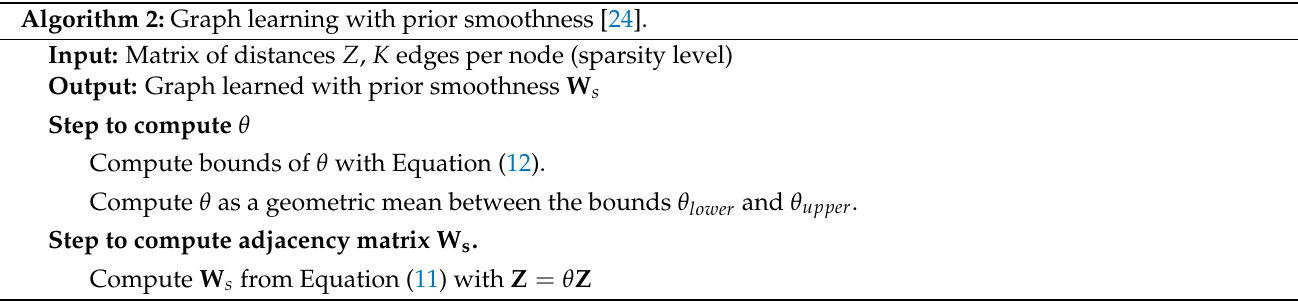
Algorithm 2: Graph learning with prior smoothness